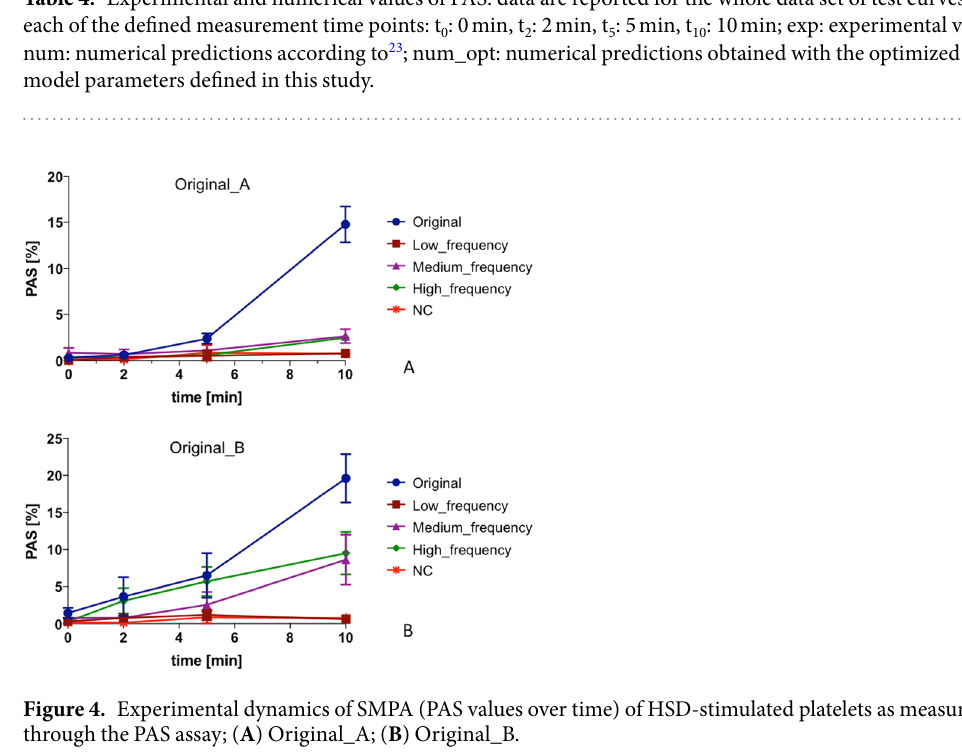
Table 4: data are reported for each of the defined measurement time-points (0, 2, 5 and 10 min). Experimental dynamics of platelet activation. According to our in vitro measurements of platelet acti- vation (Fig. 4):